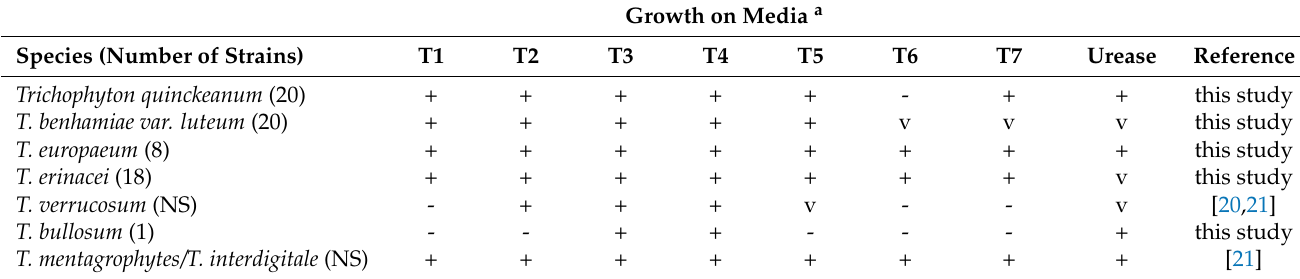
Figure 2. Geographic and temporal distribution of infections with Trichophyton quinckeanum in Czechia between 2016 and 2020. Table 3. Physiological tests results for Trichophyton quinckeanum and comparison with selected Trichophyton